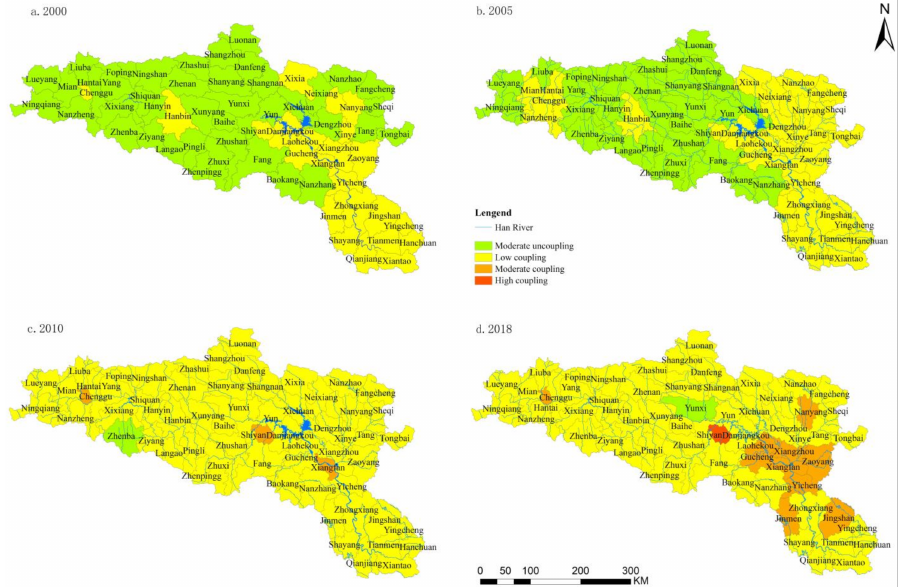
Figure 5. Spatial change trend of the coupling coordination degree between urbanization and LUMF. The ( a – d ) stand for 2000, 2005, 2010, and 2018